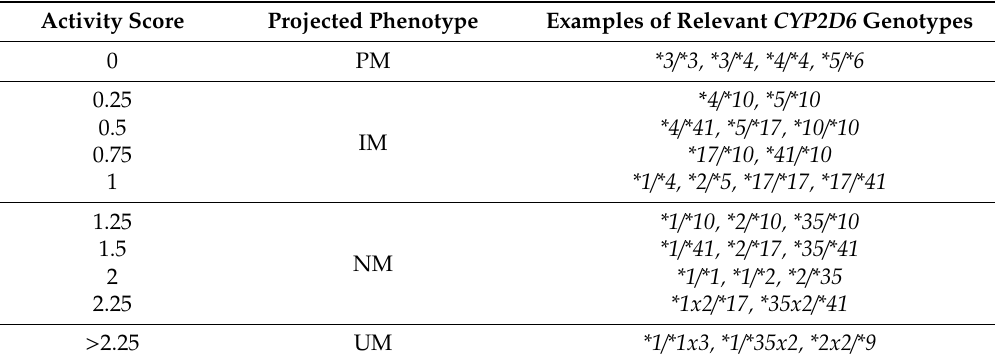
Table 1. CYP2D6 activity score assignment according to